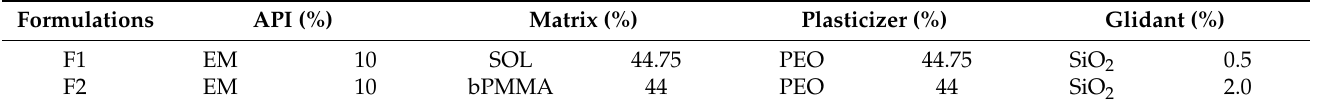
Table 1. Formulation composition for the production of HME